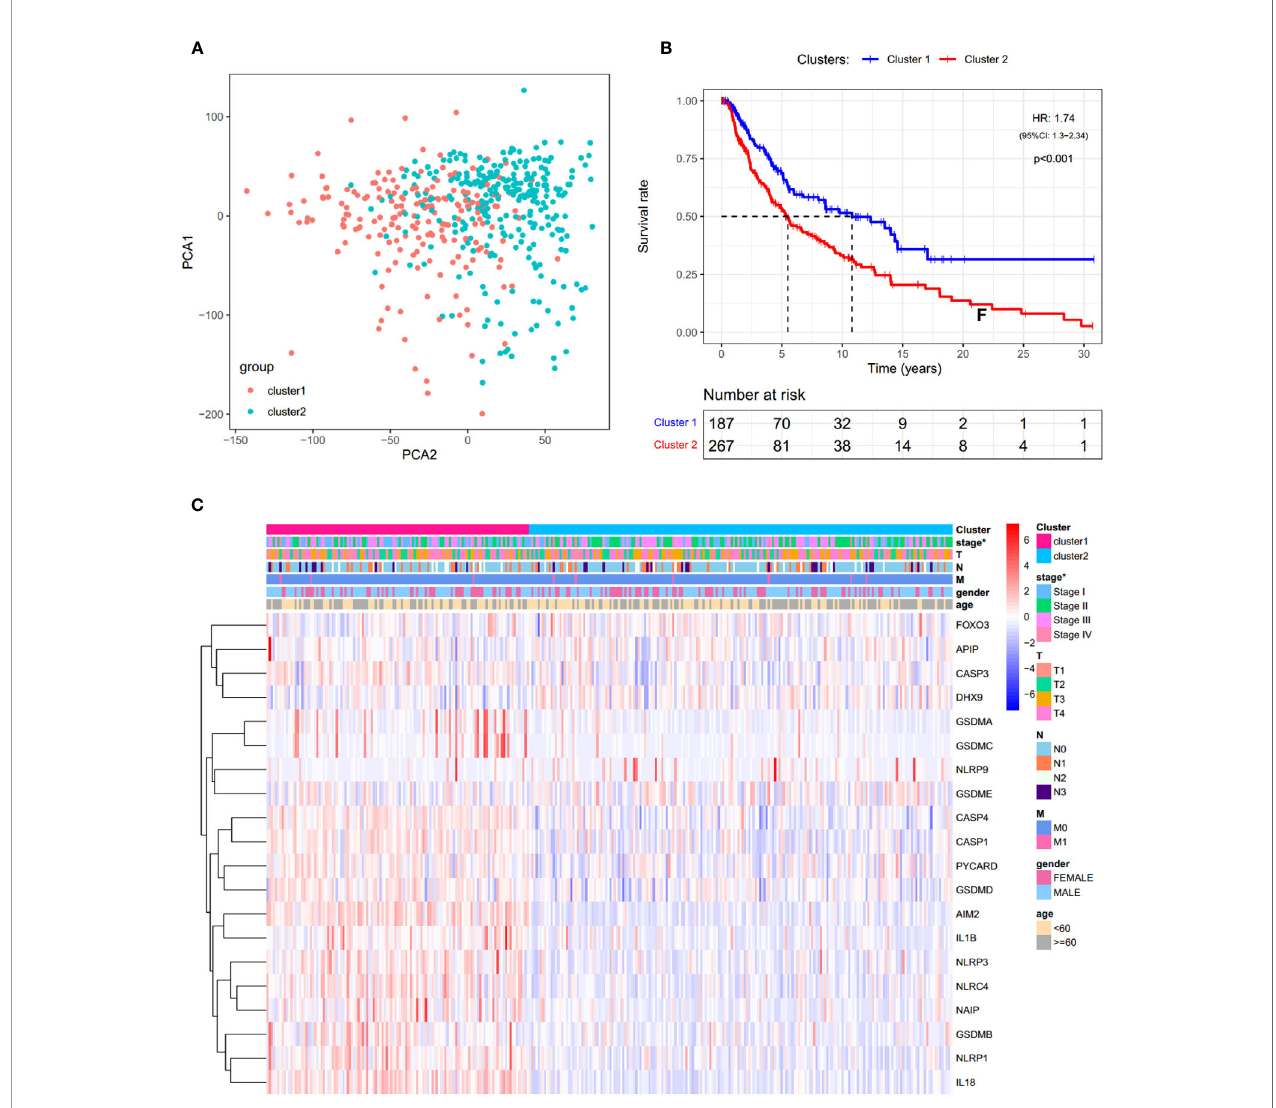
FIGURE 4 | Consensus clustering analysis of PRGs. (A) PCA plot for clusters. (B) KM curves showing the OS of cluster 1 (blue) and cluster 2 (red). HR, hazard ratio. CI, con fi dence interval. (C) Heatmap and the clinical characters of the two clusters (T, N, and M are the tumor node metastasis classi fi cation) (* p < 0.05).